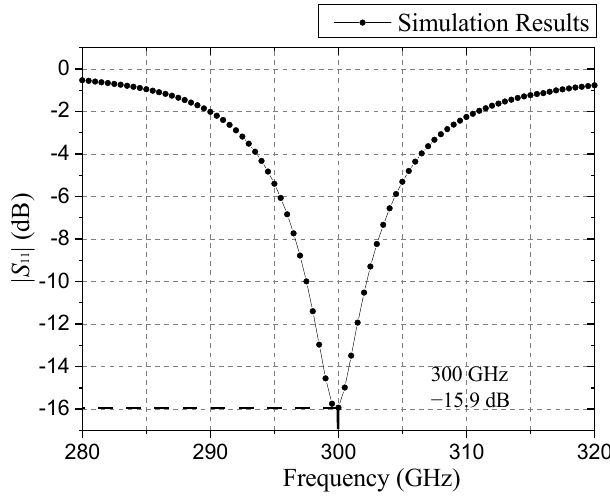
Figure 5. | S 11 | of simulation results.